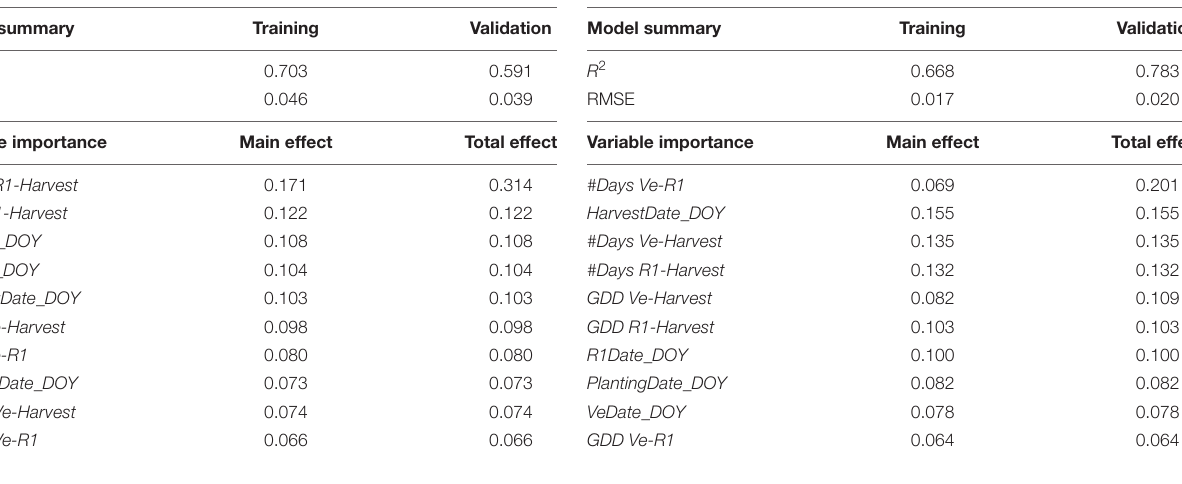
TABLE 5 | Neural Network Analysis model with NTanH(10) summary of training and validation model and variable importance assuming dependent resampled inputs for the prediction of response variable Edamame Harvest Quality Index ( EHQI ) based on phenological (Ve, emergence; R1, first flower) day-of-year (DOY), and thermal functions (GDD, growing degree days) for soybean cultivar